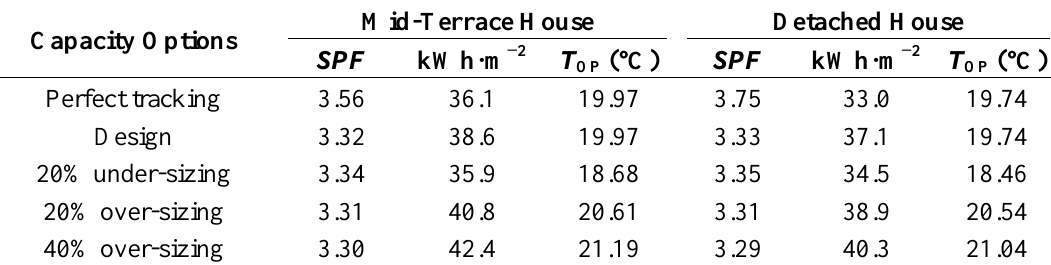
Table 5. Sensitivity to heating system sizing and